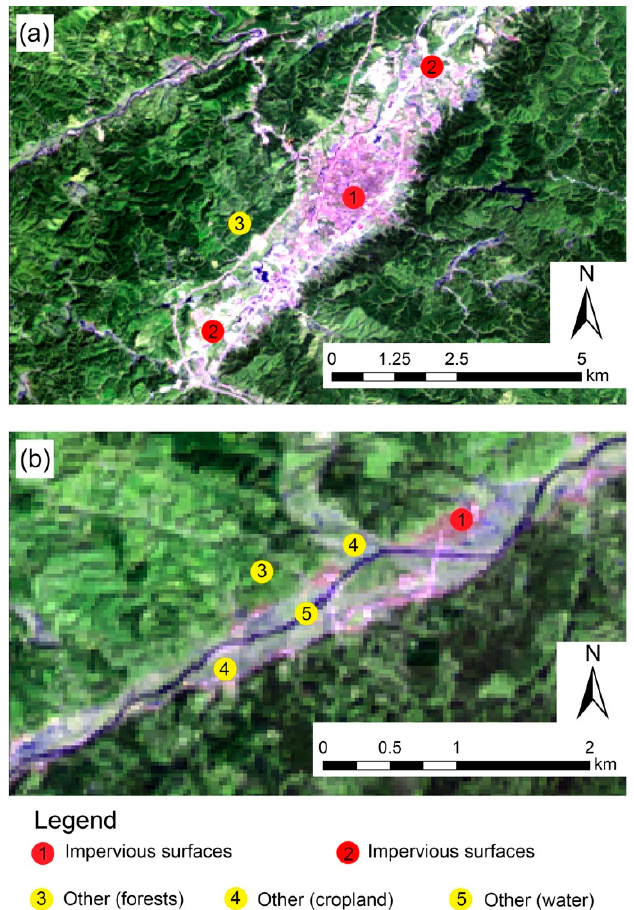
Figure 2. A false-color composite for the creation of training samples ( a ) at the county seat, and ( b ) at a